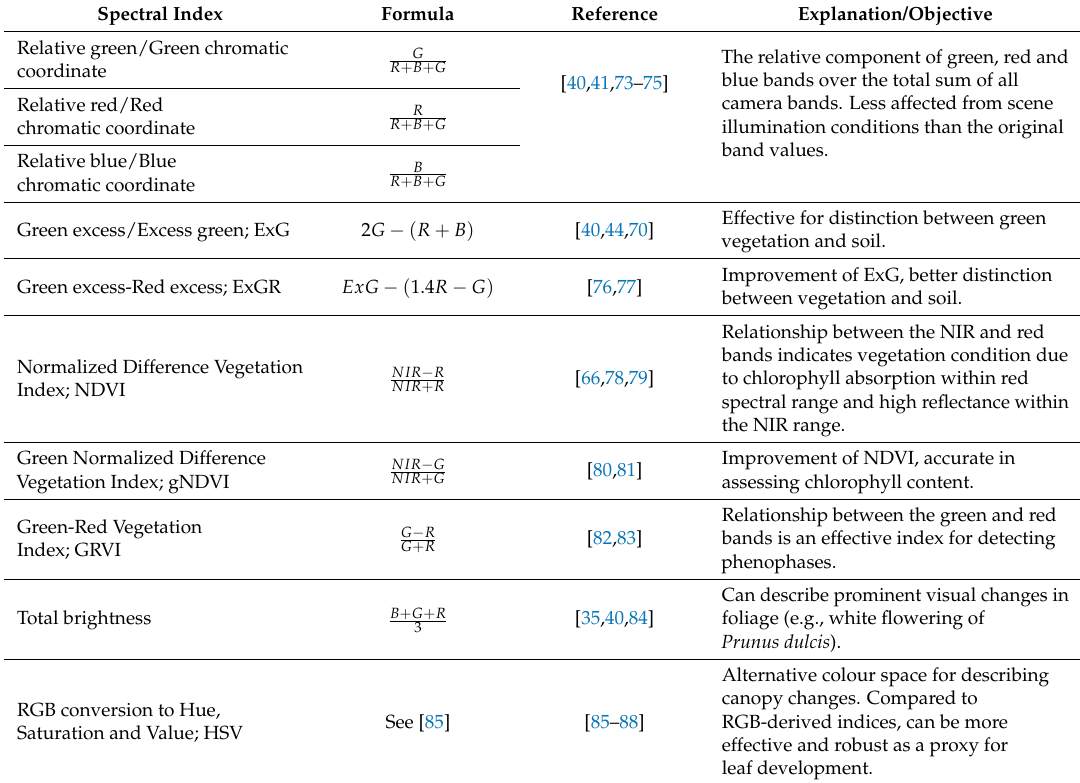
Table 2. List of the spectral indices and color conversions that were calculated from the near-surface original spectral